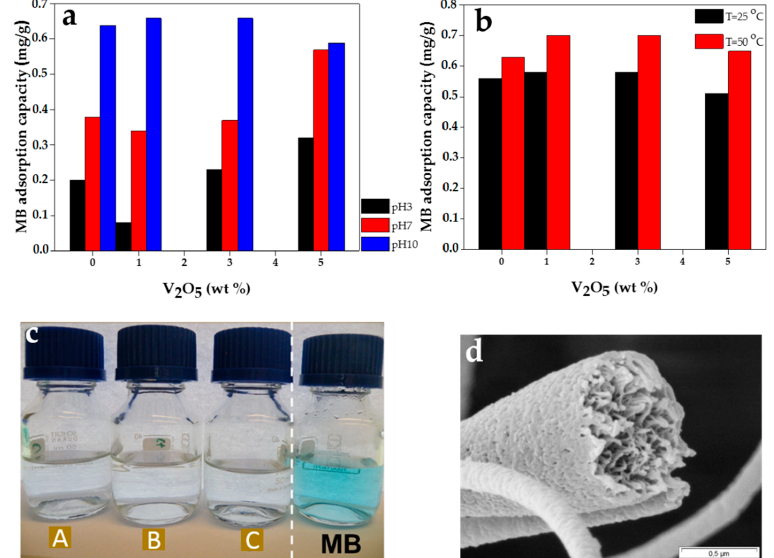
Figure 3. Methylene blue (MB) adsorption capacity of ENAs versus V 2 O 5 content considering the effect of ( a ) pH and ( b ) temperature (at alkaline pH); ( c ) camera image of the purified aqueous solutions after adsorption process at hot and alkaline conditions versus the primary MB solution (A–C: treated by PES, 1 wt % V 2 O 5 /PES and 5 wt % V 2 O 5 /PES ENA, respectively); ( d ) porous internal and